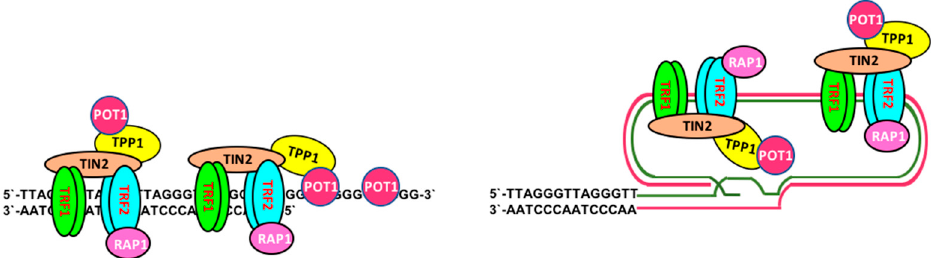
Figure 1. Schematic illustration of the structure of telomeres. The telomere repeats are coated by shelterin, a complex of six proteins that bind to DNA either directly (TRF1, TRF2, and POT1) or indirectly (TIN2, RAP1, and TPP1). The shelterin induces the formation of a T-loop by invasion of the single-stranded overhang into double-stranded telomeric DNA. TRF: telomeric repeat-binding factor; POT1: protection of telomeres 1; TIN2: TRF1-interacting nuclear factor 2; RAP1: repressor-activator protein 1.